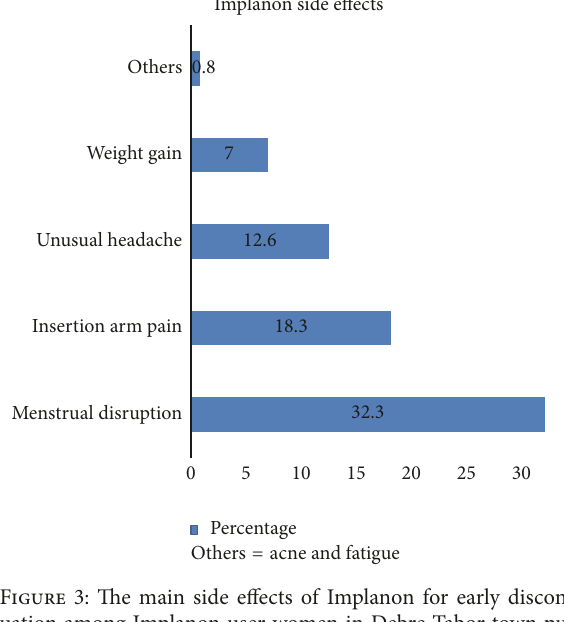
Figure 3: The main side effects of Implanon for early discontin- uation among Implanon user women in Debre Tabor town public health facilities, South Gondar Zone, Amhara Region, 2016.